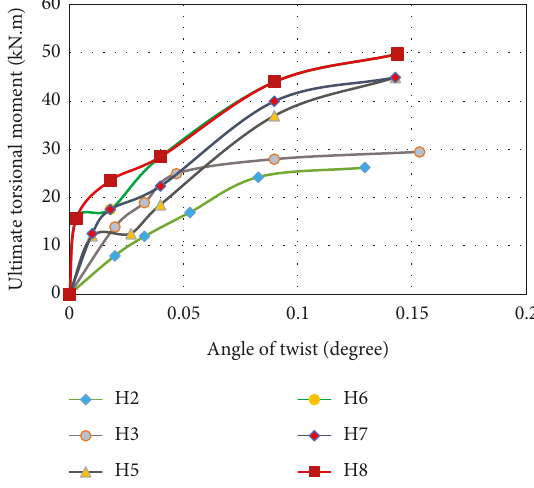
Figure 14: Torque-twist relationship. Table 12: Effect of increasing the longitudinal steel number on the twist